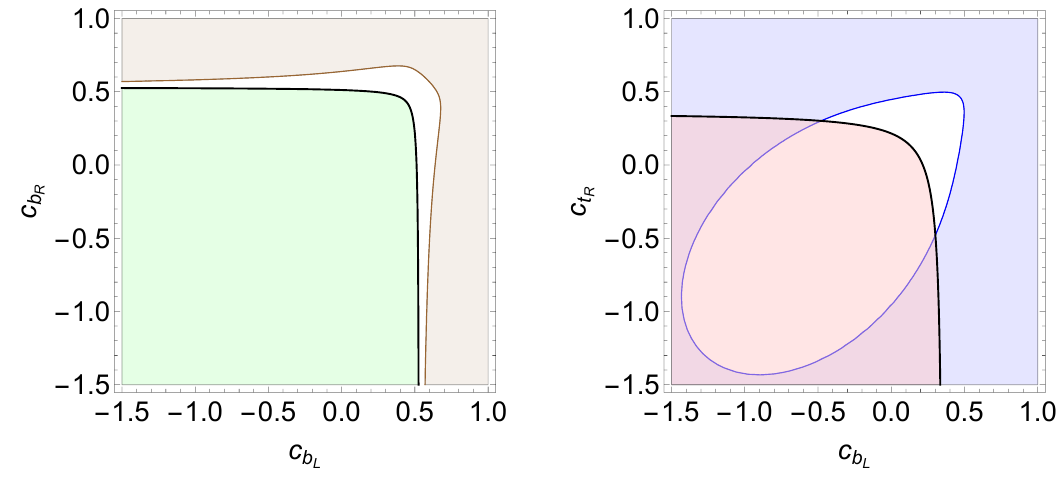
; c b ) compatible with the (cid:13)avor constraints for L R